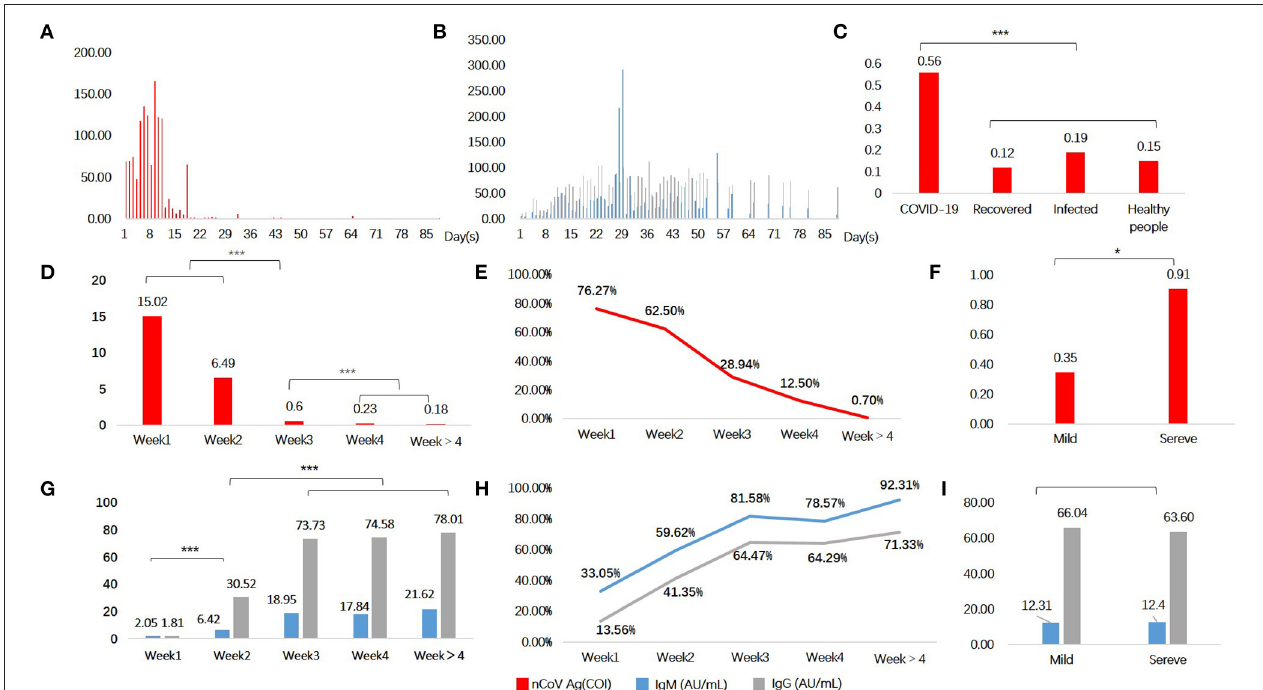
FIGURE 1 | Serological testing in COVID-19 patients and controls. Serum N protein antigen (A) and specific antibodies (B) as a function of time since symptoms onset. Antigen (C,D,F) and antibodies (G,I) levels in different groups. Positive rate of serum antigen (E) and antibodies (H) . Red denotes antigen, blue and grey denote specific antibodies IgM and IgG, respectively. * P < 0.05, *** P < 0.001, and lines without *mean no statistical